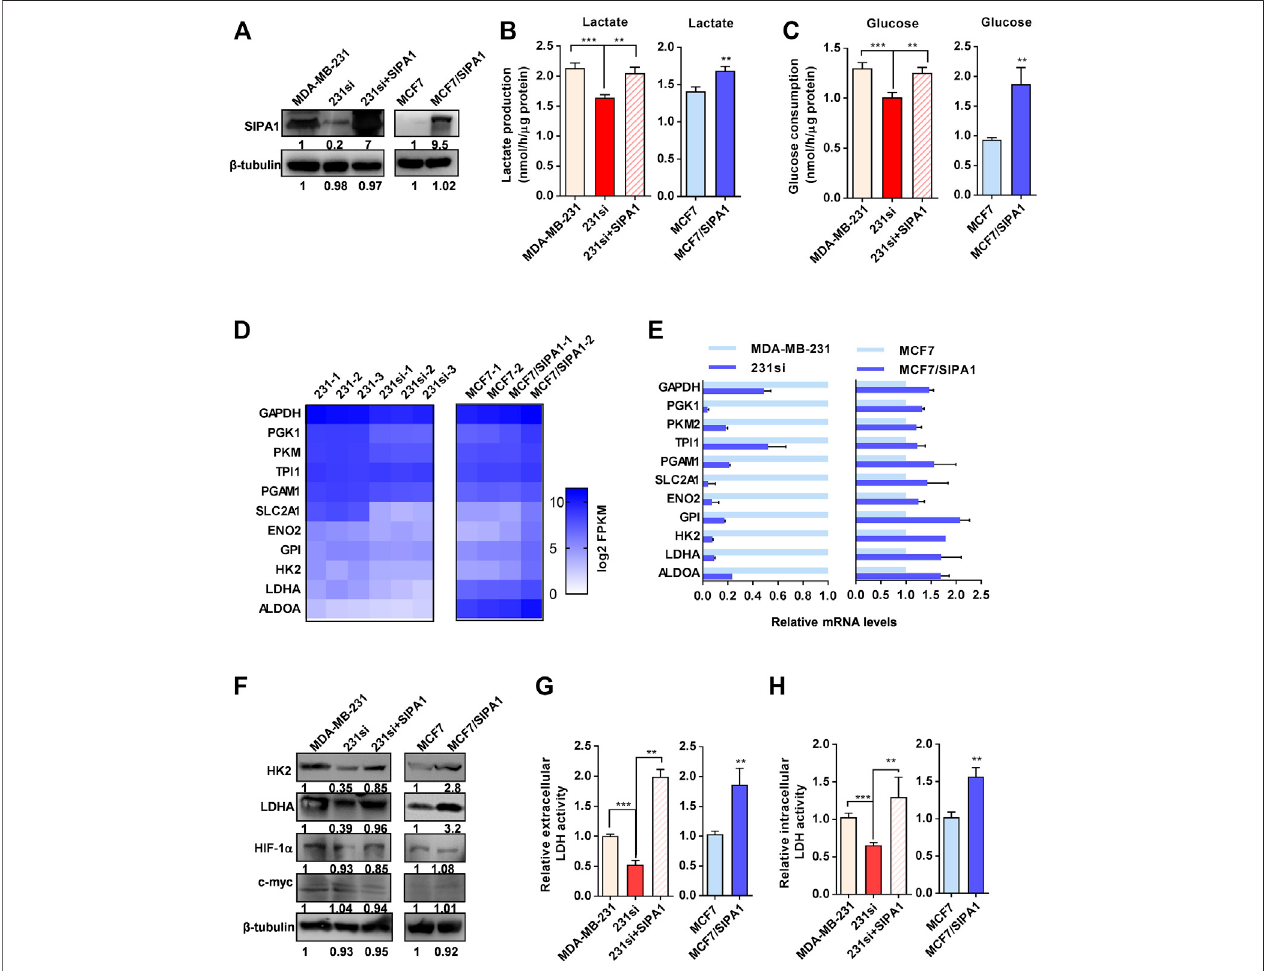
FIGURE 1 | SIPA1 enhances aerobic glycolysis in breast cancer cells under a normoxic condition. (A) SIPA1 protein expression levels in breast cancer cells were determined by Western blotting analysis. 231si (SIPA1-knocked down MDA-MB-231); 231si + SIPA1 (SIPA1-resumed 231si); MCF7/SIPA1 (SIPA1 overexpressed MCF7). β -tubulin was included as a loading control. (B – C) Effect of SIPA1 on the lactate production (B) and the glucose consumption (C) in breast cancer cell lines. (D) Heatmapof mRNAlevels ofmajor glycolysis-related genes inthree independent parental and SIPA1-knockdown MDA-MB-231 cells, and twoindependent